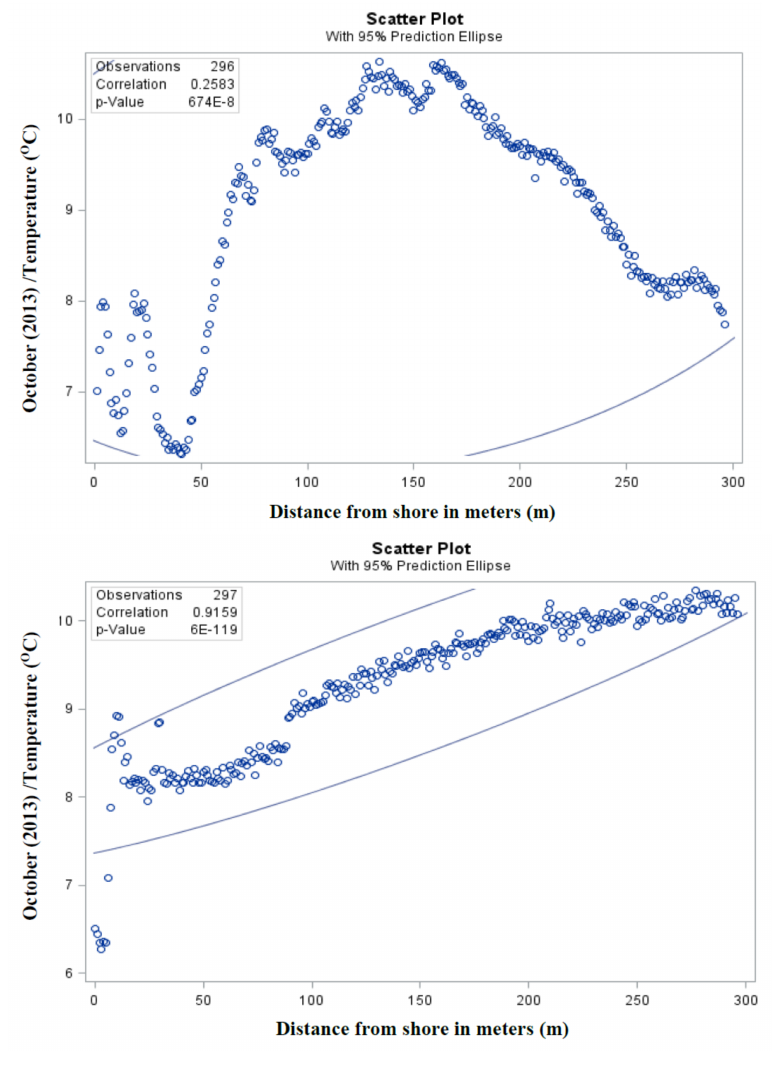
Figure 7. Plot showing Pearson’s correlation between October 2013 temperature and distance at Suvilahti in the city of Vaasa. Ketunkatu (above) and Liito-oravankatu (below). The meaning of p -value = 674E − 8 = 674 × 10 − 8 ( above ). The meaning of p -value = 6E − 119 = 6 × 10 − 119 ( below